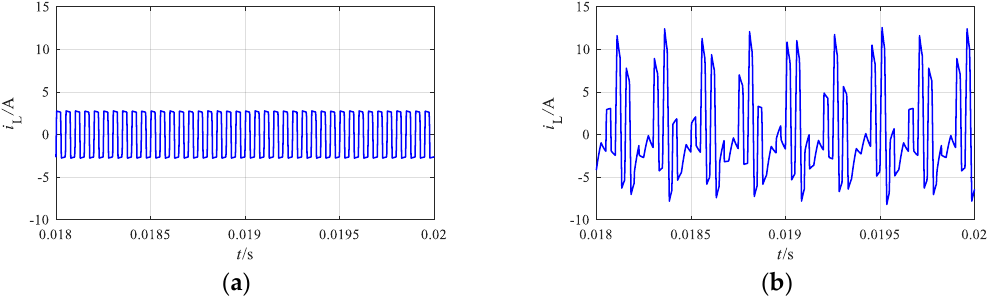
Figure 8. Waveforms of the inductor current. ( a ) Before the Hopf bifurcation ( k = 0.5); ( b ) after the Hopf bifurcation ( k = 0.65).